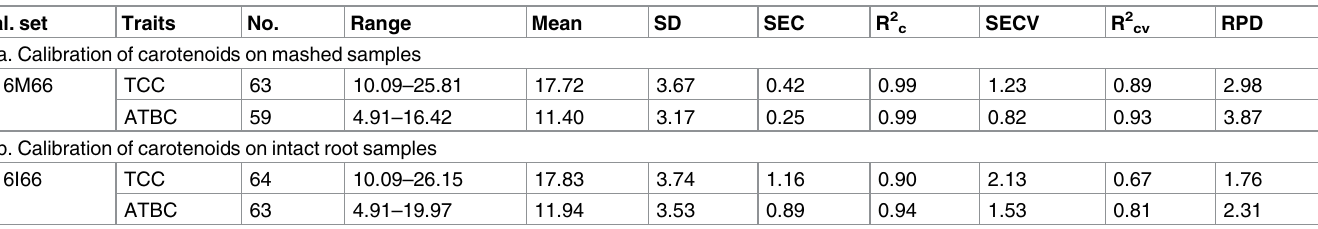
Table 6. Carotenoids calibrations from mashed (a) and intact (b) root samples from CIAT using the same sample size (n = 66). Cal.